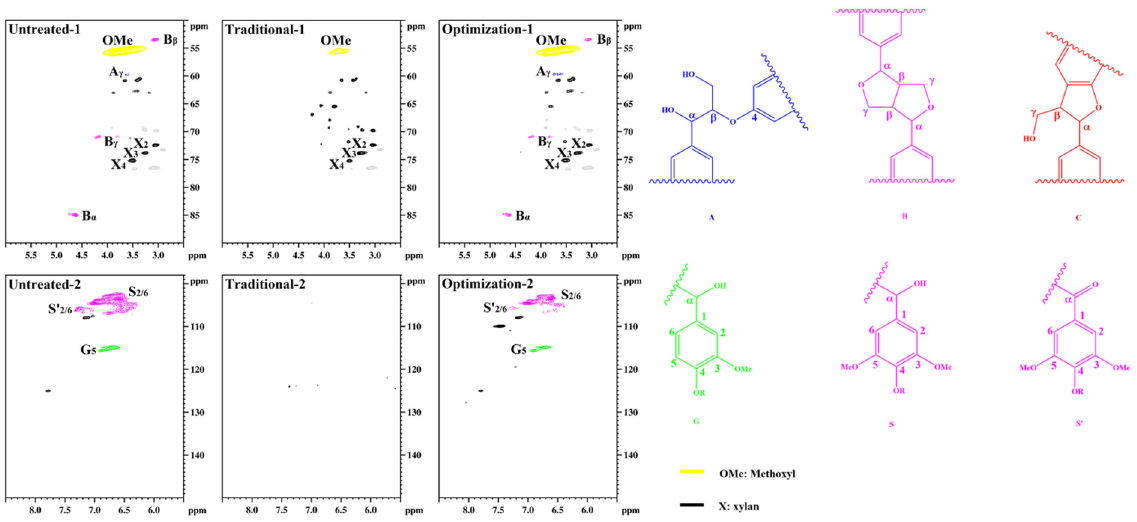
Figure 9. Structural characteristics of lignin in eucalyptus pulp.